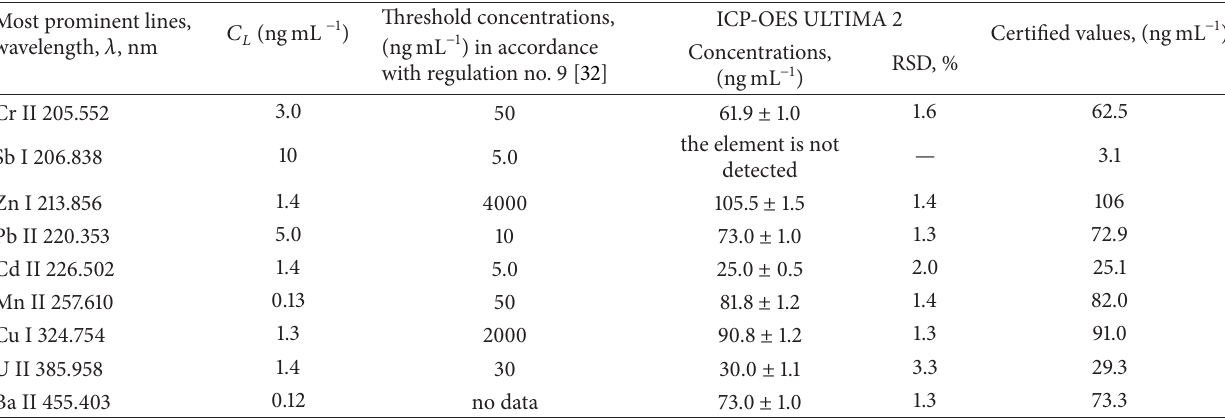
Table 7: Detection limits in pure solvent 𝐶 𝐿 (column 2) obtained by ULTIMA 2 by using the most prominent lines of Cr, Sb, Zn, Pb, Cd, Mn, Cu, U, and Ba (column 1) under optimal experimental conditions (Table 1), threshold concentrations in accordance with Bulgarian Regulation No. 9 on the quality of water intended for human consumption [32] (column 3), mean values [ 𝑋 ] for ( 𝑛 = 4 replicates), and the confidence interval of the mean value [ Δ𝑋 ] for statistical confidence 𝑃 = 95 % and 𝑓 = 𝑛 − 1 = 3 (column 4) as well as the RSD (column 5) of the analytical results obtained by ICP-OES in the determination of Cr, Sb, Zn, Pb, Cd, Mn, Cu, U, and Ba in NWRI TMDA-51.2 (column 4) . Column 6 shows the certified